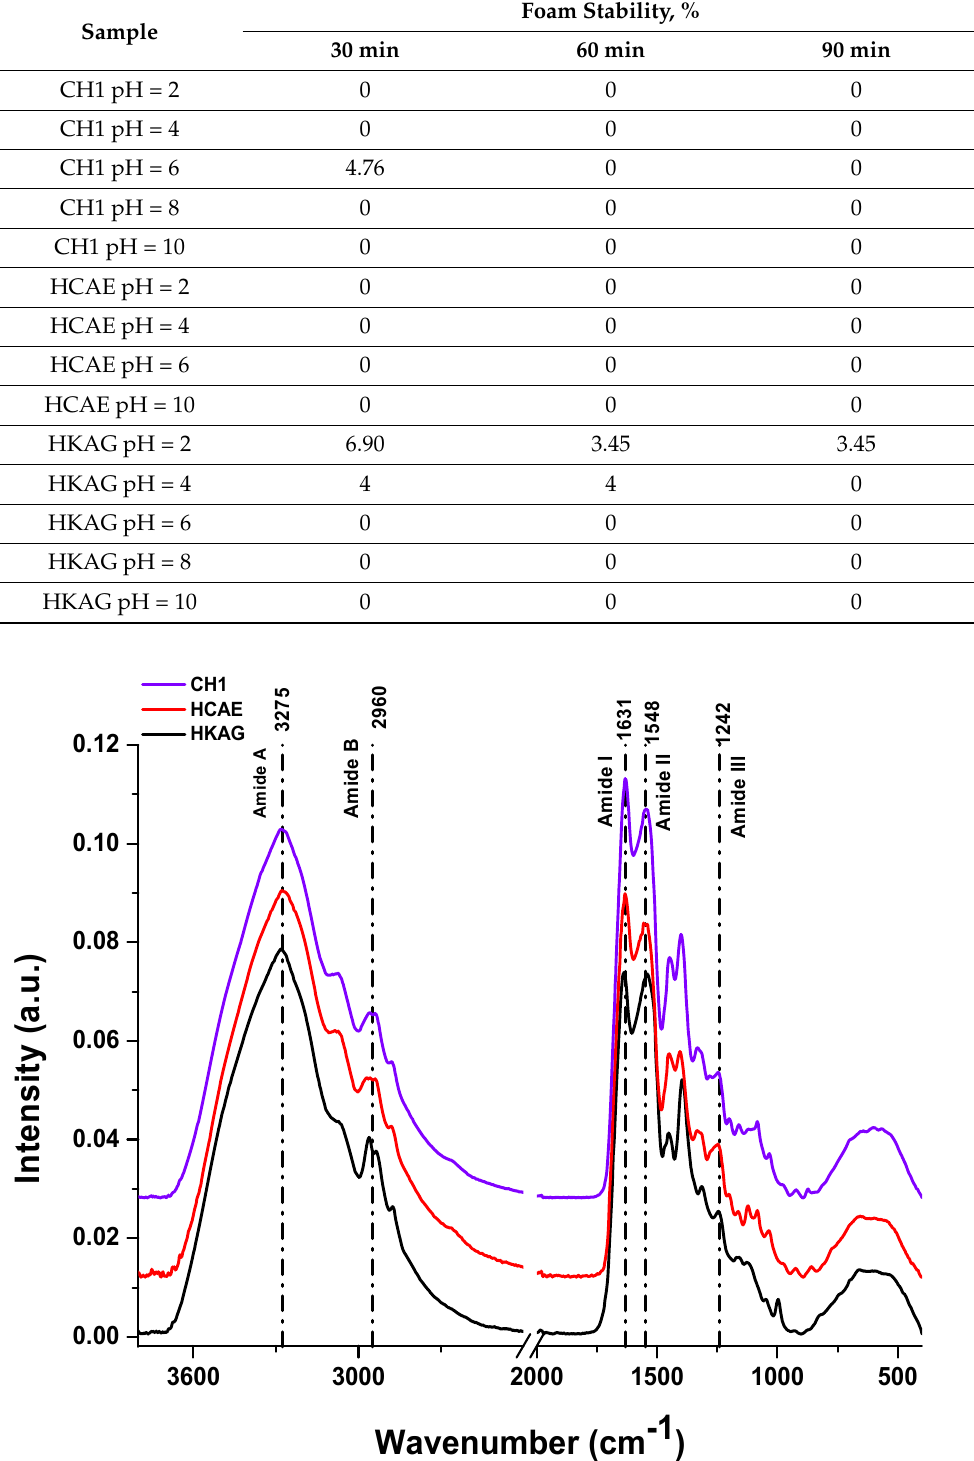
Figure 6. ATR ‐ FTIR spectra of CH1, HCAE, and HKAG protein hydrolysates. Figure 6. ATR-FTIR spectra of CH1, HCAE, and HKAG protein hydrolysates. The ATR FT-IR spectra of protein hydrolysates showed the presence of specific major The ATR FT ‐ IR spectra of protein hydrolysates showed the presence of specific amide bands providing information on secondary structure that was still preserved after major amide bands providing information on secondary structure that was still the extraction processes. The band Amide A was associated with the N-H group stretching preserved after the extraction processes. The band Amide A was associated with the N ‐ H vibrations and occurred in the range of 3300 cm − 1 wavenumbers. The shift to group stretching vibrations and occurred in the range of 3300 cm − 1 wavenumbers. The shift to lower frequencies (3275 cm − 1 ) was due to involvement of NH groups of peptides